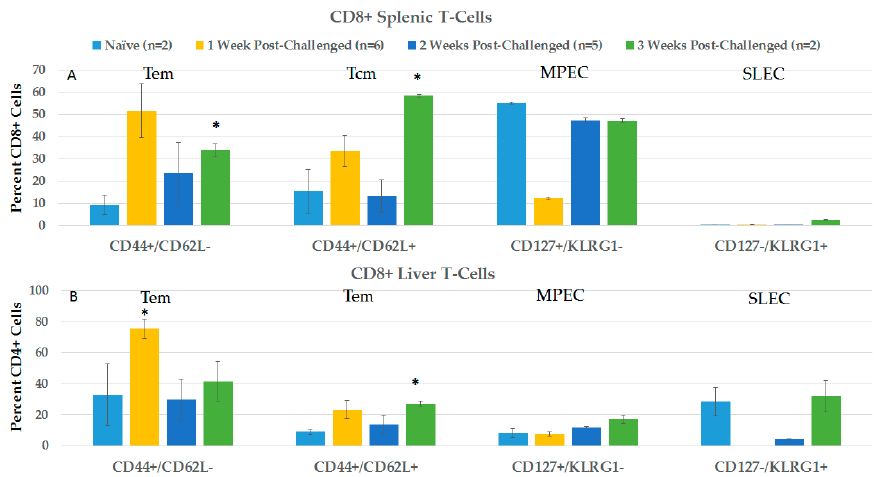
Figure 9. Spleen and liver CD8+ T-Cell analysis post-challenge. Lymphocytes were isolated at various times post-challenge from spleen ( A ) and liver ( B ) and then stained with CD4, CD8, CD44, CD62L, CD127 and KLRG1. Analyses were done on CD8+ cells. Naïve and 3 weeks n = 2, 1 week n = 6 and 2 weeks n = 5; error bars = SEM. * p <